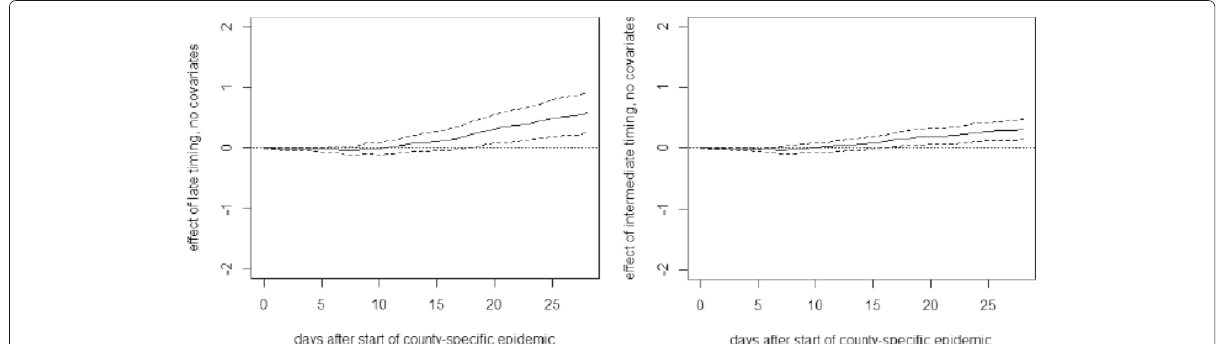
Fig. 11 OLS effects of late (left) and intermediate (right) timing of measures on cumulative deaths per 10,000 inhabitants without covariates